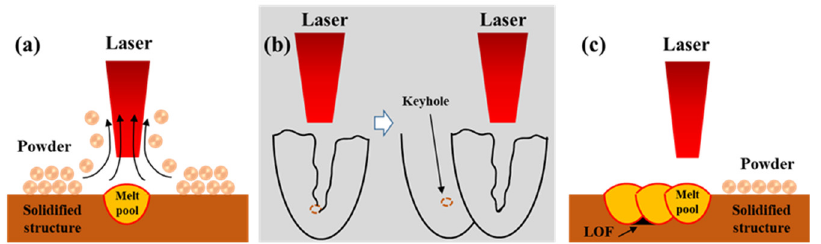
Figure 5. Schematic diagram of defect formation: ( a ) denudation, ( b ) keyhole, and ( c ) LOF pore.